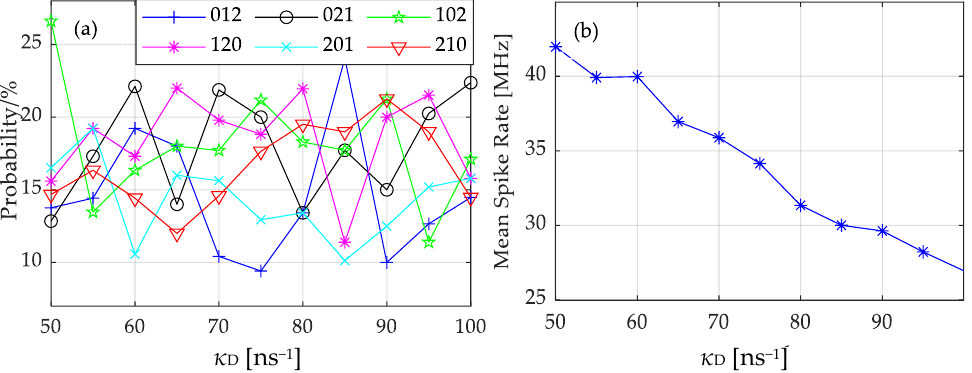
Figure 3. Word probability ( a ) and pulse rate ( b ) of the drive laser at different feedback